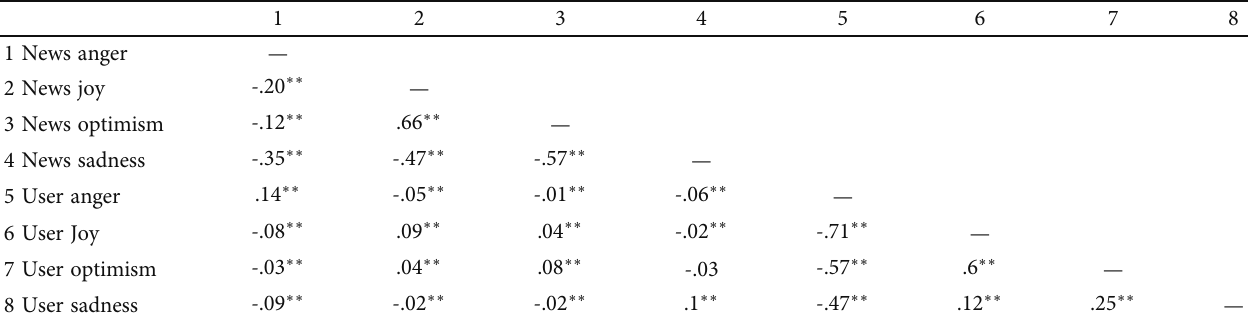
Table 5: BBC News (UK) correlation matrix showing Spearman ’ s Rho coe ffi cients between news and user emotion scores.